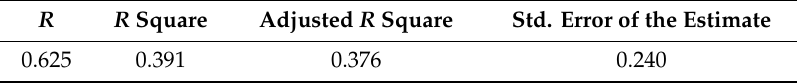
Table 4. Model summary of the developed MLR model.